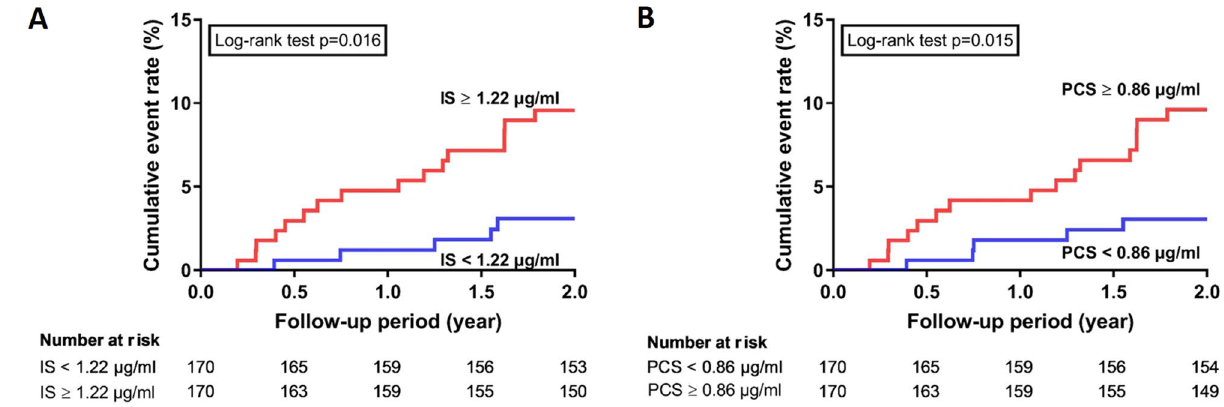
Figure 5. The Cumulative incidence of acute coronary syndrome in patients stratified by median level of protein-bound uremic toxins ( A ) Free form indoxyl sulfate ( B ) Free form p-cresyl